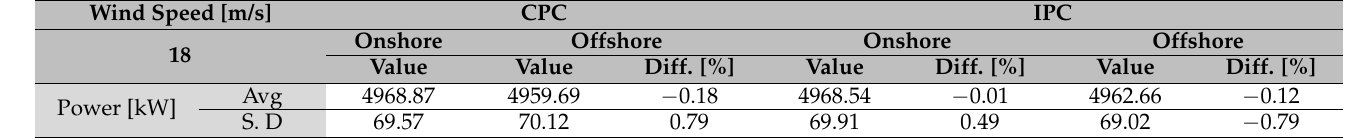
Table 5. Average value and standard deviation of output data based on pitch controller in 18 m/s.